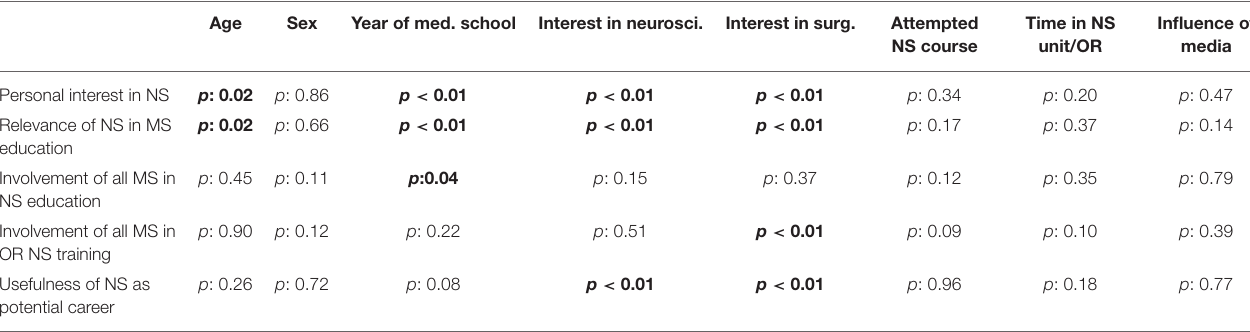
TABLE 7 | Results of univariate statistical analysis. Age Sex Year of med. school Interest in neurosci. Interest in surg. Attempted